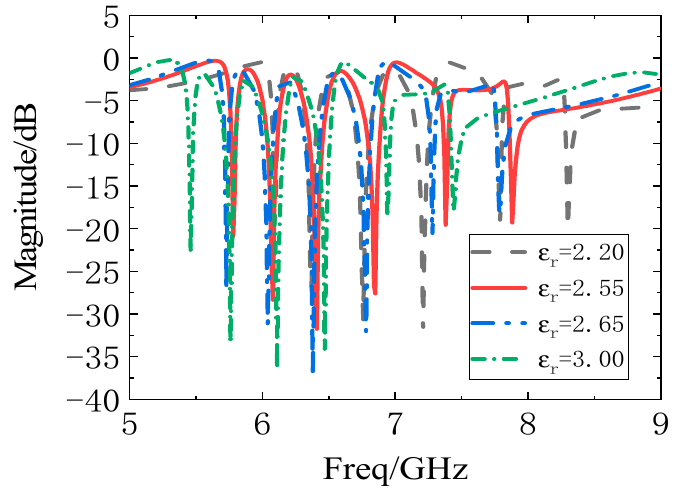
Figure 16. Resonance curves of U-shaped slot resonator with different dielectric